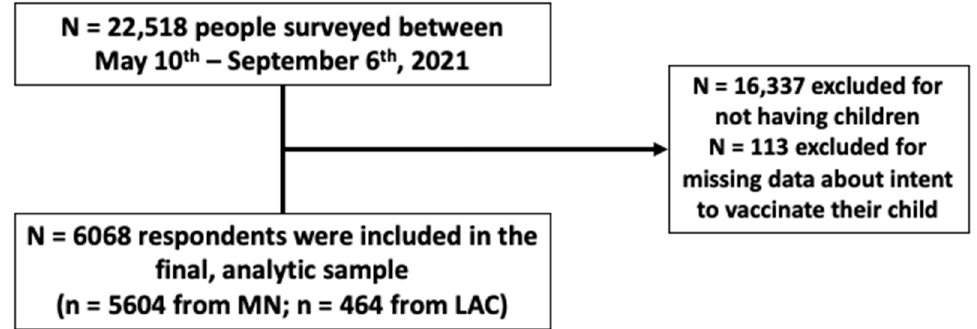
Figure 1. STROBE Figure 1. STROBE diagram. Table 1. Demographic and social characteristics of parents by vaccination intent status.